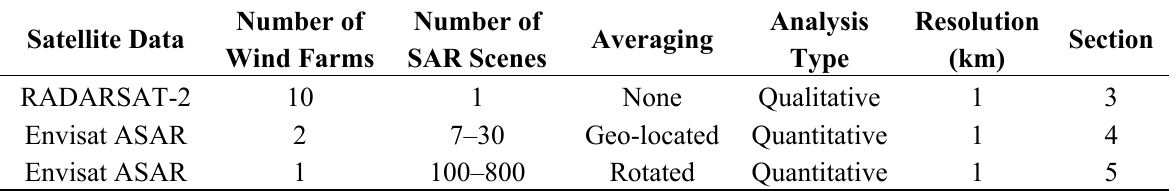
Table 1. SAR source, number of wind farms covered in the method, number of SAR scenes used in each method for wake identification based on no averaging, geo-located SAR wind field averaging and rotated SAR wind field averaging. The spatial resolution of the wind fields are given. The Section in this paper where each mode is presented is also